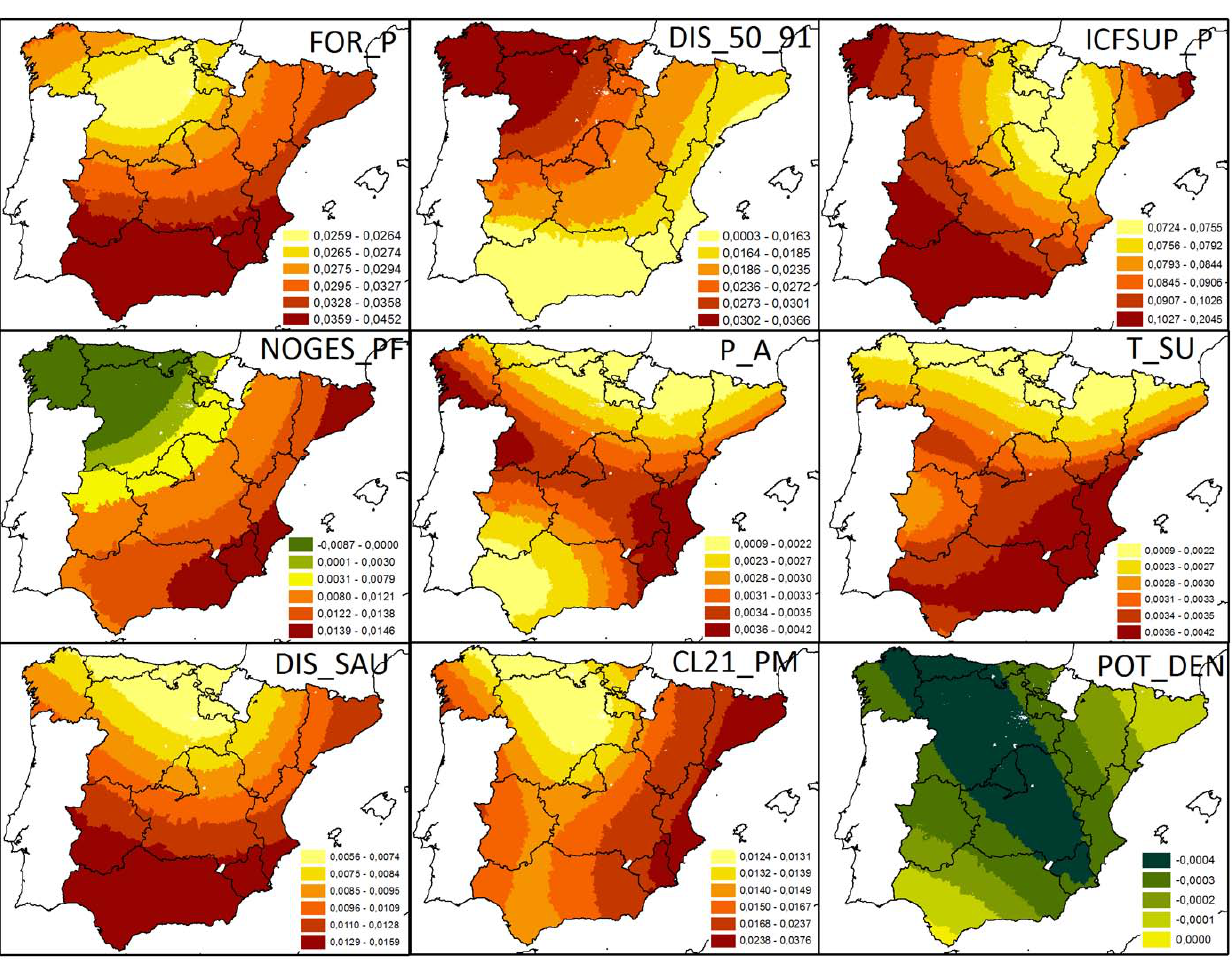
Fig. 6. Local coefficients for GW binary logistic model using a fixed bandwidth of 219km. Negative coefficients are mapped with cold colours (green) and positive with warm colours (orange to red). Variable names and their descriptions are in Table 1. Table 4. Moran’s Index Summary for different band distances on the Linear GWR